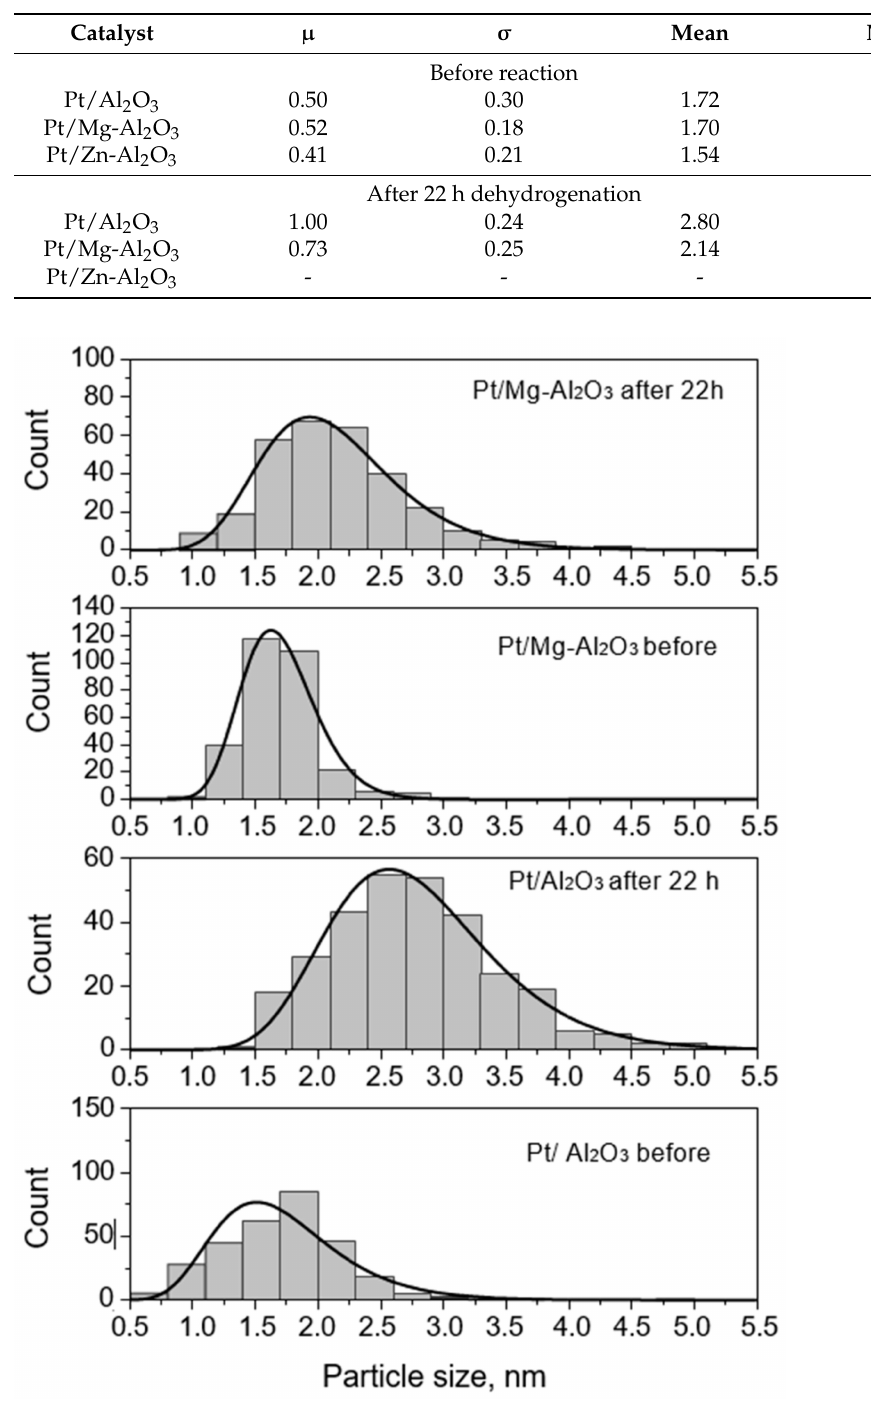
Figure 10. Platinum nanoparticles’ size distribution before and after dehydrogenation, experiments carried out at 300 ◦ C for 22 h using a fixed bed